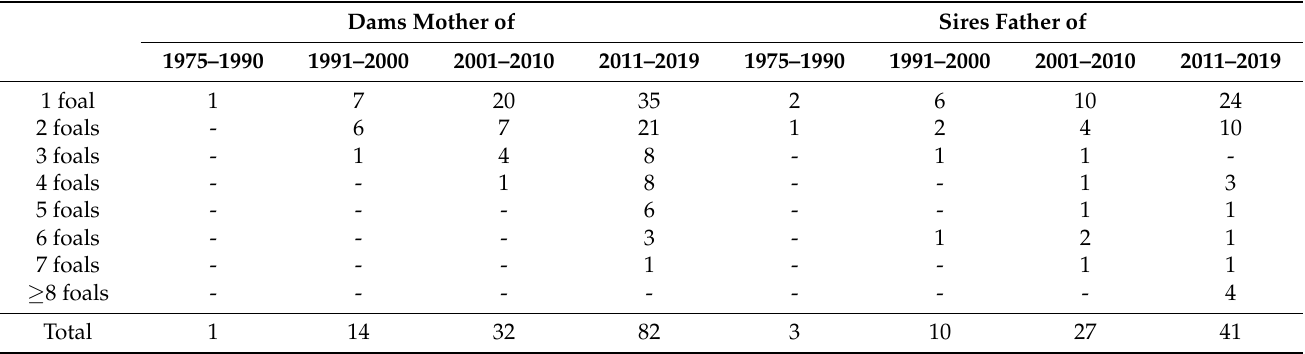
Table 4. The number of dams and sires per number of their foals in each generation interval period. Dams Mother of Sires Father of